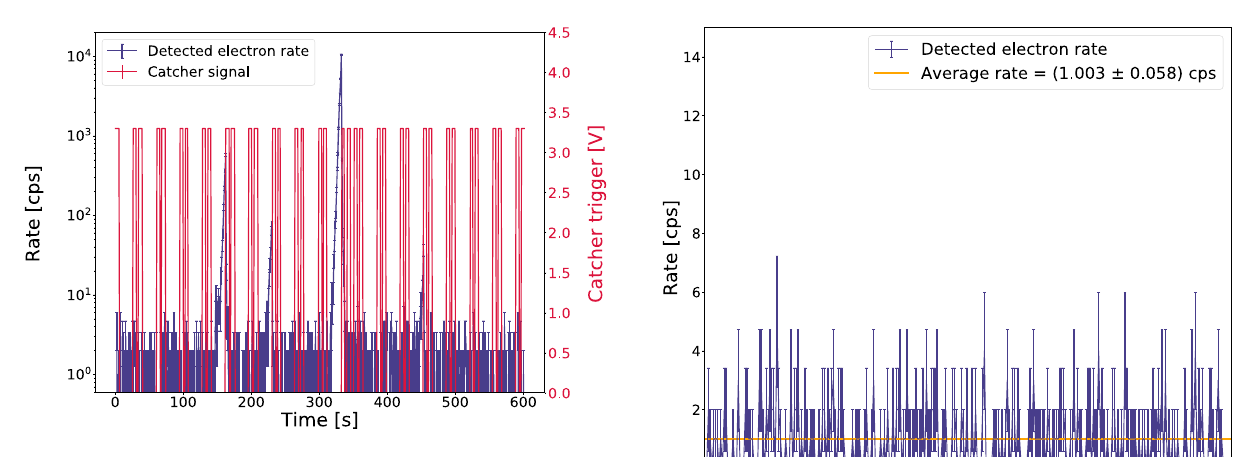
Fig. 9 Focal Plane Detector background electron rate for setting A, Table 1 and the electron catcher operated in a mode in which it moved in a repeated pattern of 4 s inside the flux tube, 4 s outside the flux tube, 4 s inside the flux tube, and 30 s outside the flux tube; however, when the safeguard script was triggered by an FPD rate higher than 10 kcps, the catcher was inserted an additional two times (each time for 4 s, with 4 s in between)